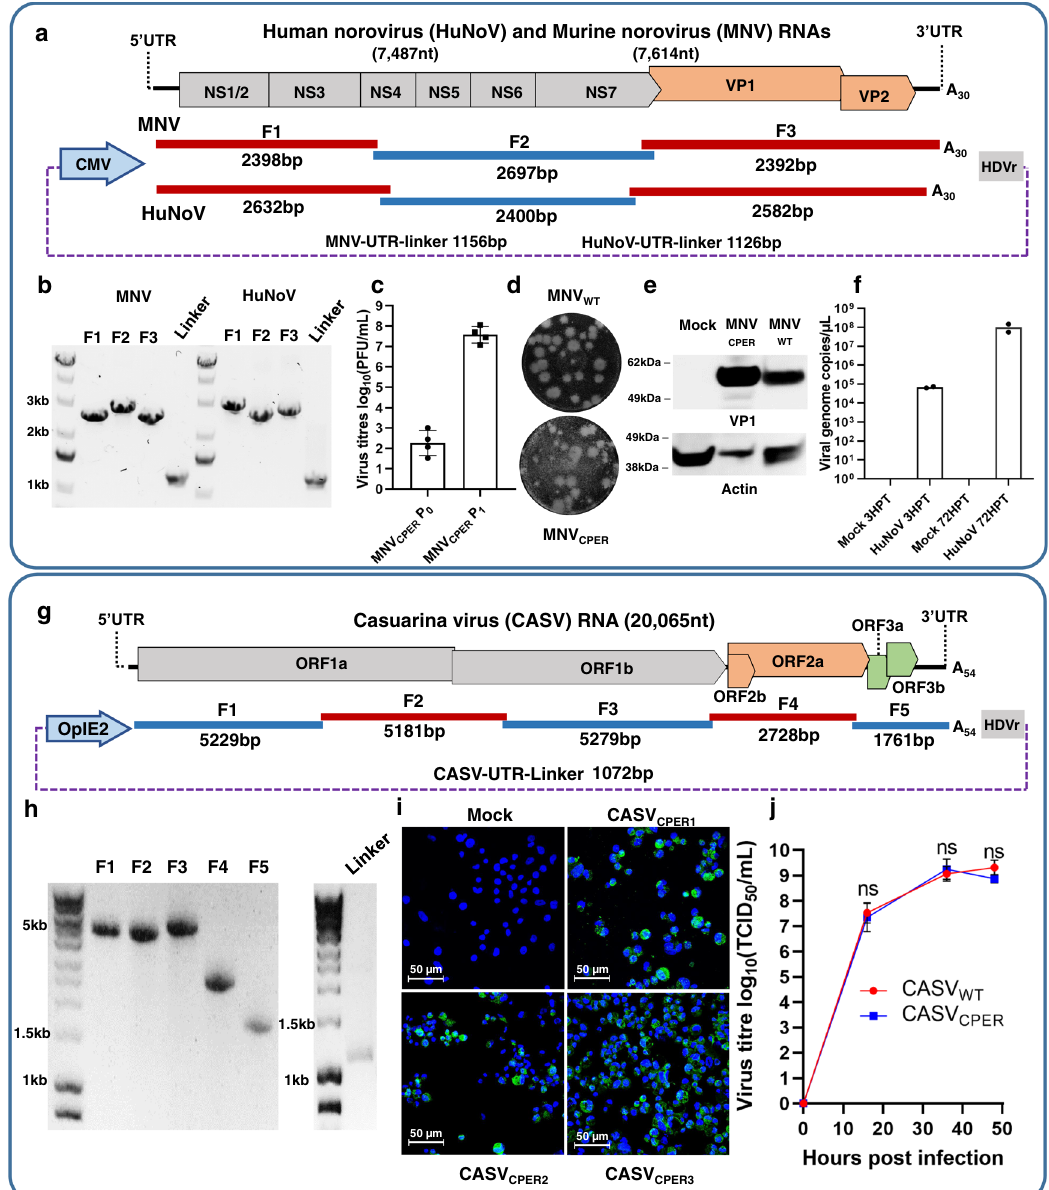
Fig. 4 Generation of mouse and human noroviruses and insect-speci fi c mesonivirus CASV by CPER and their characterization. a Schematics of